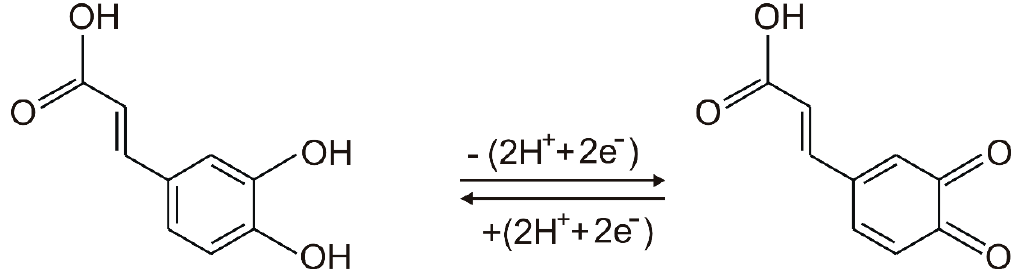
Figure 4. The mechanism of reversible redox process of caffeic acid.